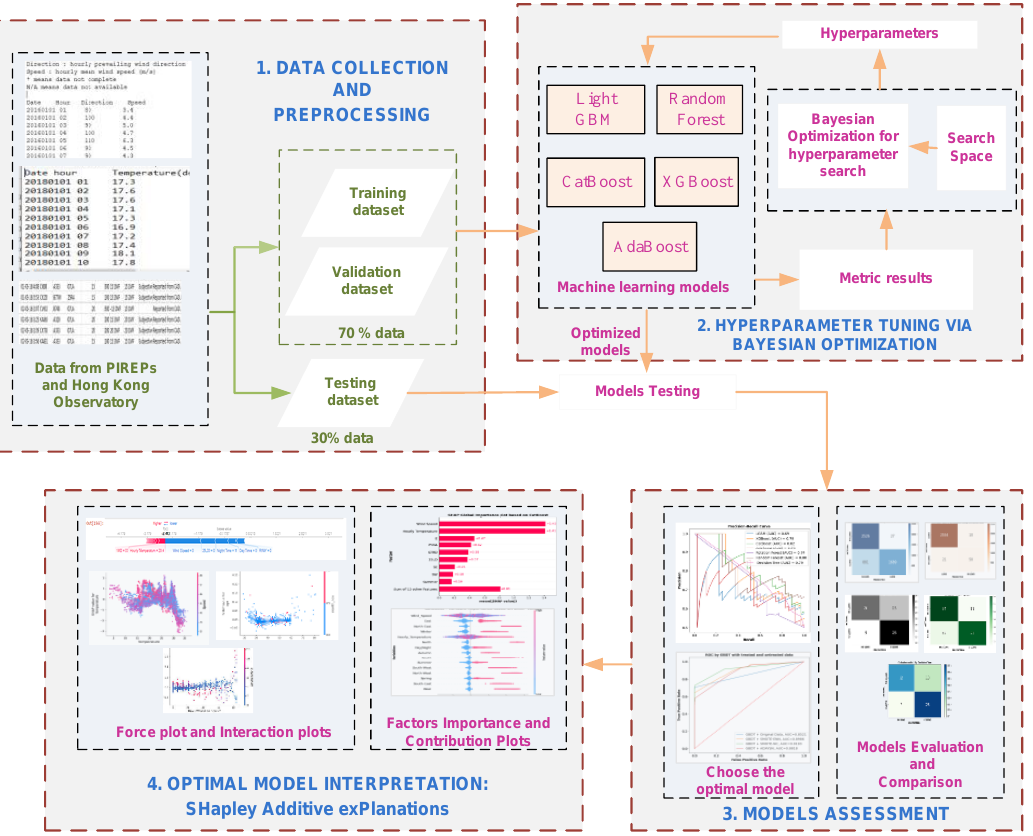
Figure 3. Framework for the prediction and interpretation of LLWS criticality at the vicinity of runways at HKIA.